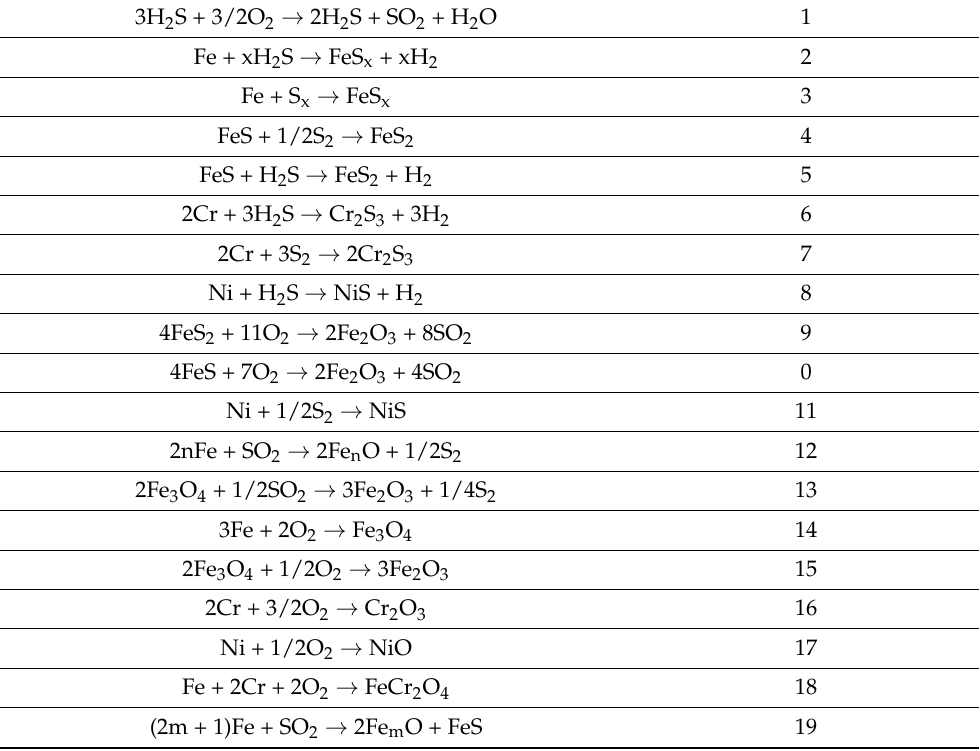
Table 4. Assumption of chemical reaction in the present